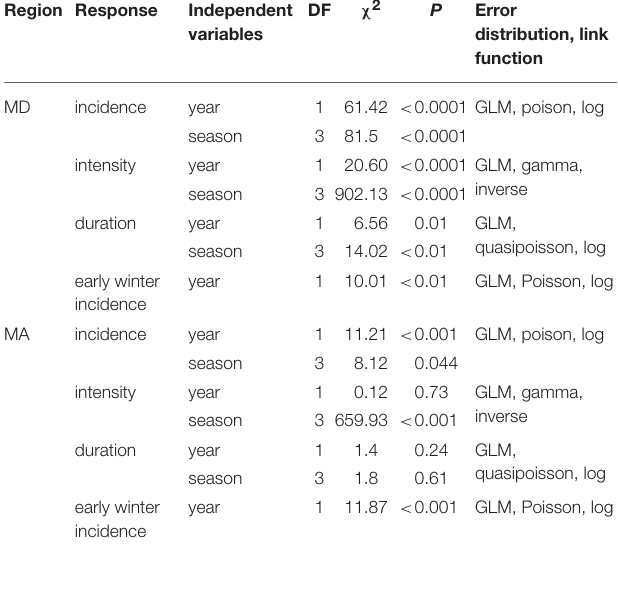
TABLE 4 | GLM summaries for the analysis of heatwave incidence, intensity and duration in MD and MA during the period of 1894 to 2011.